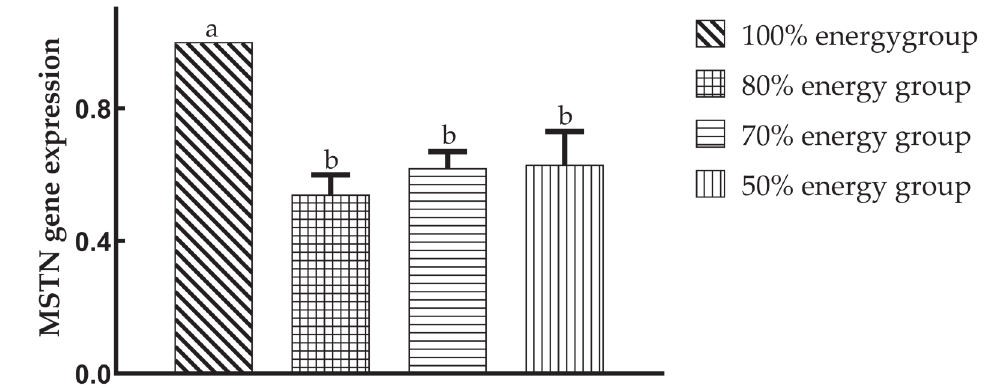
Figure 2. Effects of maternal dietary energy restriction on the relative expression of the myostatin ( MSTN ) gene of offspring breast muscles on the 49th day. Total RNA was isolated from the left side breast muscles according to standard TRIzol extraction procedures. The quality of total RNA was examined by ethidium bromide-stained denaturing agarose gel electrophoresis. The concentration of RNA was determined by a spec- trophotometer. RNA samples were stored at –80°C before use. The polymerase chain reaction primers were designed according to the sequence of those genes in chickens in GenBank by Primer 5.0 and synthesized by the Beijing BGI Company, China. Each reaction was carried out in a total volume of 20 μL, consisting of 10.0 μL SYBR Premix Ex, 0.8 μL each primer, 2.0 μL cDNA and 6.0 μL ddH O. Amplification reactions in triplicate for 2 each sample were performed, and the results were normalized to the GAPDH gene expression level. Compared with the 100% energy group (1.00±0.00 a ), the expression of the MSTN gene in the offspring was significantly decreased (p<0.05), but there was no significant difference (p>0.05) among the maternal dietary energy restriction groups, 0.54±0.06 b , 0.62±0.05 b , 0.63±0.10 b , individually, on the 49th